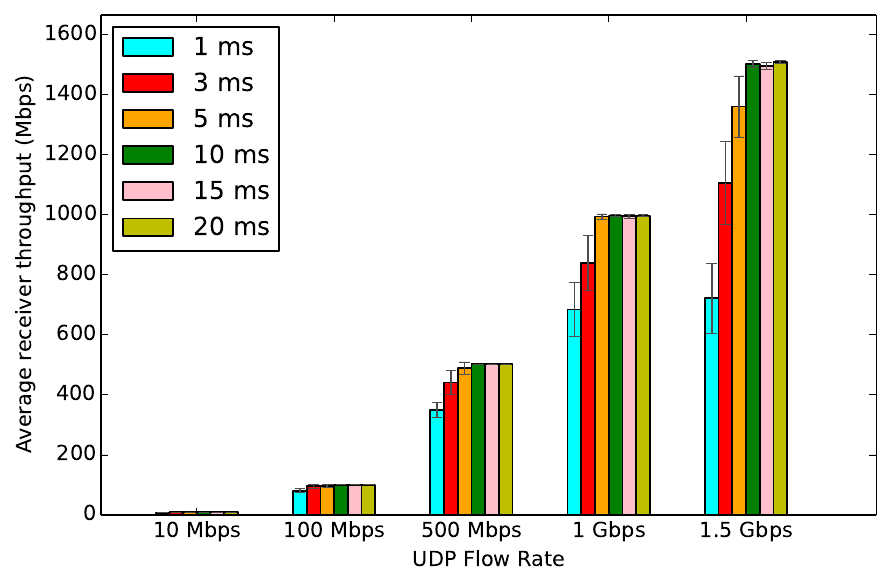
Figure 11. Measured throughput in N4 with different BFD intervals.